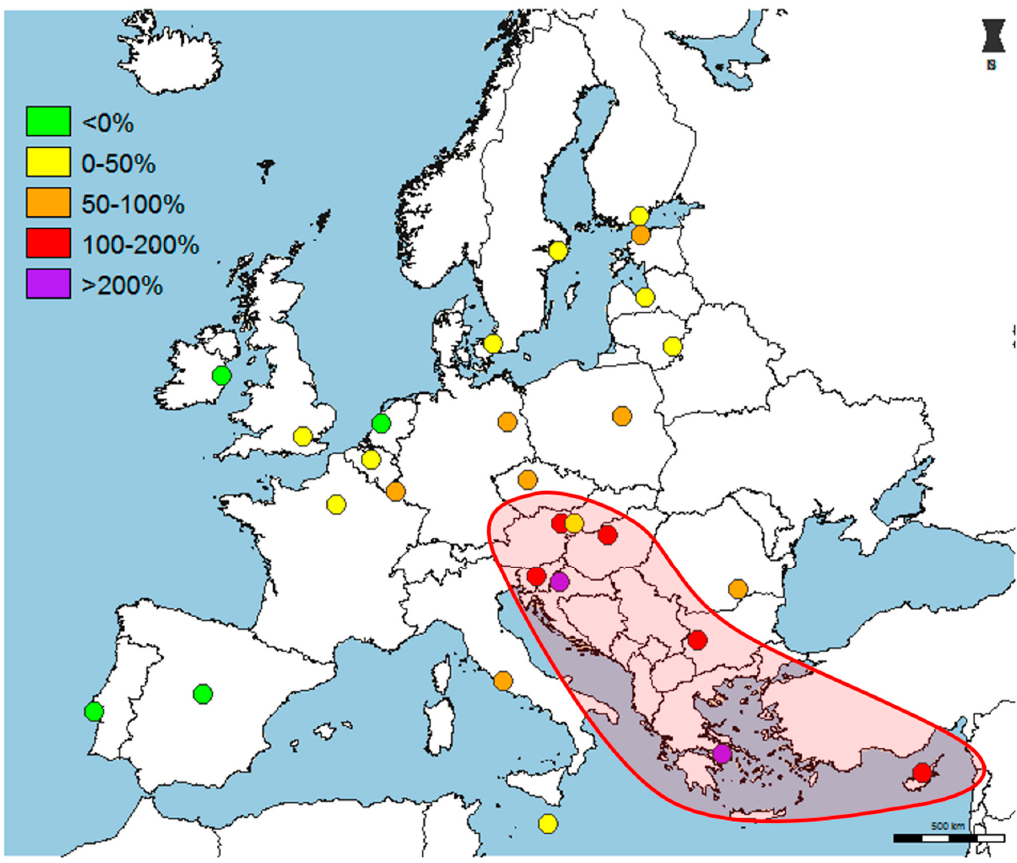
Figure 3. The percentage change of the Heatwave Hazard Index (HWHI) in the sub-period 1998–2015 compared with the sub-period 1980–1997 in the capitals of the 28 EU Member States. The color keys indicate the five HWHI% change-classes. The red highlighted area is a continuous geographic area with HWHI increases above 100%.